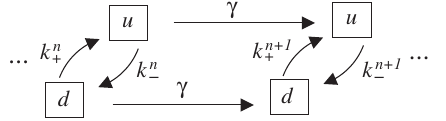
FIG. 7. Two-state model with a stochastic protocol. The states of the systems d and u have energies 0 and E n , respectively. The protocol changes from n to n þ 1 with a rate γ .